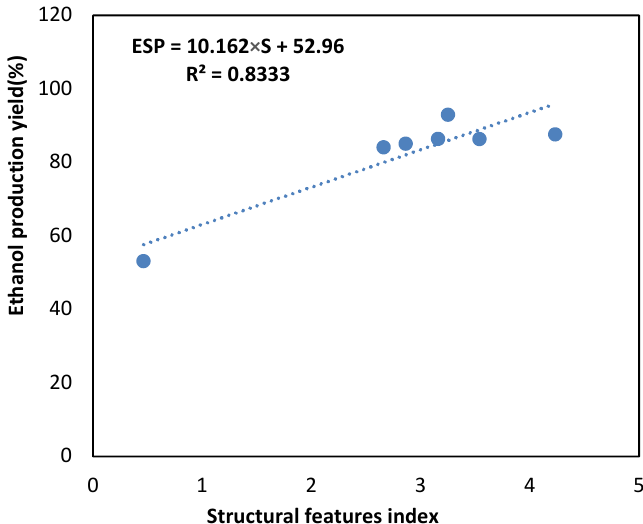
Figure 6. Linear relationship between ethanol production yield and structural features index of pinewood.